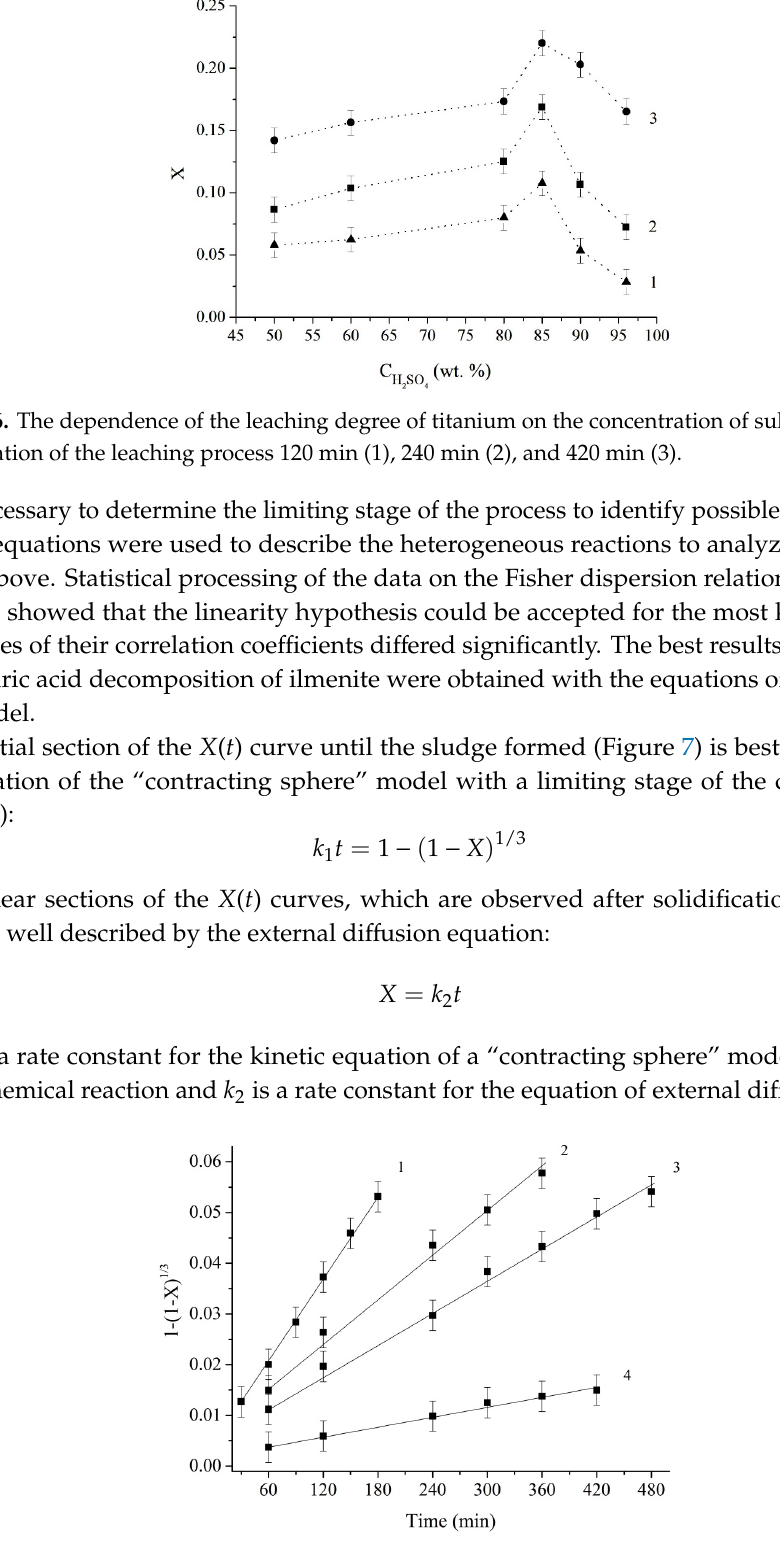
Figure 7. Dependence of the titanium leaching degree on time during the sulfatization of the ground ilmenite concentrate in the coordinates of the equation of the “contracting sphere” model with the limiting stage of the chemical reaction (8), grinding time of 2 h, temperature of 100 ° С , and the sulfuric acid concentrations of: 1–85 wt%; 2–80 wt%; 3–60 wt%, 4–50 wt%. The dissolution rate of ilmenite will increase with a dilution of the acid and the shape of the kinetic curve will change. The rate constants for the titanium extraction from ilmenite concentrate were compared with the concentrations of acid solutions (Figure 7). The rate constants were calculated according to Equation (7) for the initial sections of the kinetic curves in Figures 4 and 5. It was found that the leaching process should be considered as a two-stage process for the mechanism of the ilmenite processing with sulfuric acid. This leaching process is described by Equations (7) and (8). The observed rate constant is related to the rate constant of the chemical reaction ( k *) under the condition of the kinetics of the first or pseudo-first order of chemical reaction, according to the “contracting sphere” model: